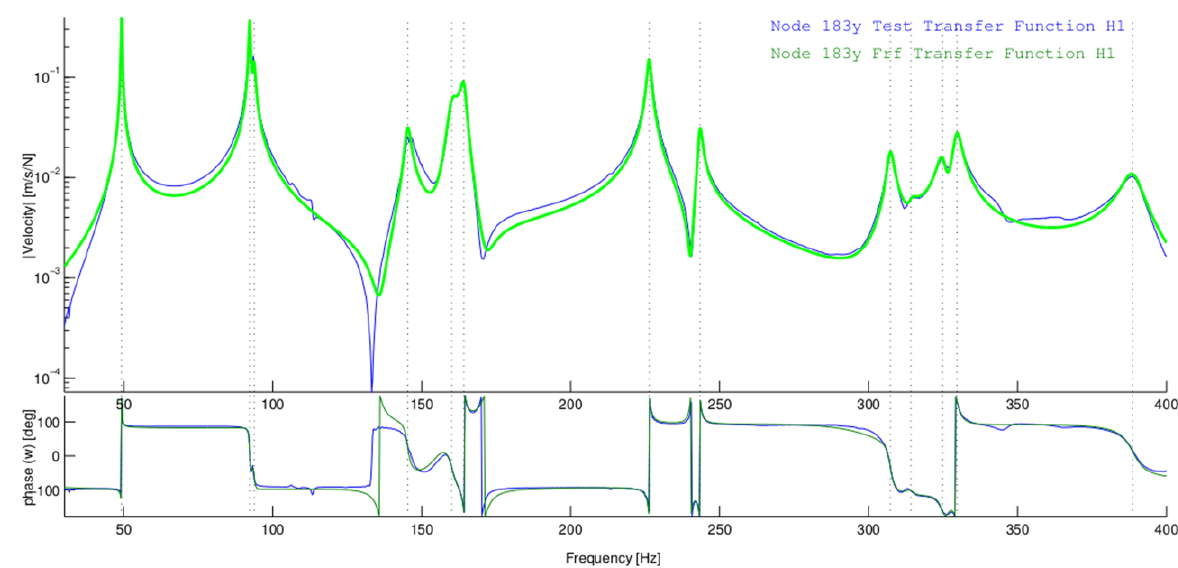
Figure 2: FRF (blue) and fitting curve (green) of composite model at node 183y [17].